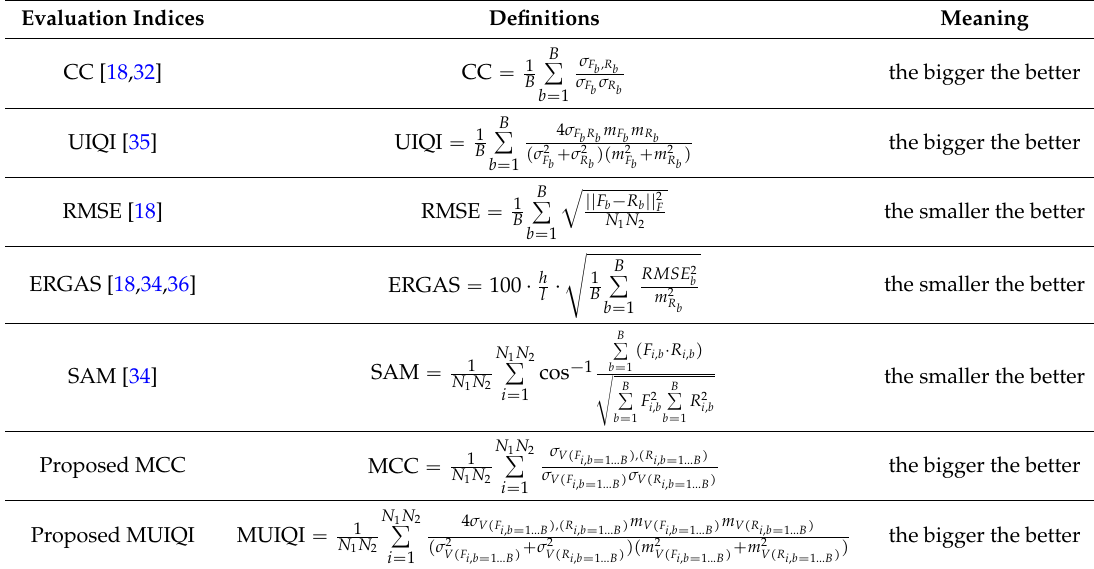
Table 1. Quantitative evaluation